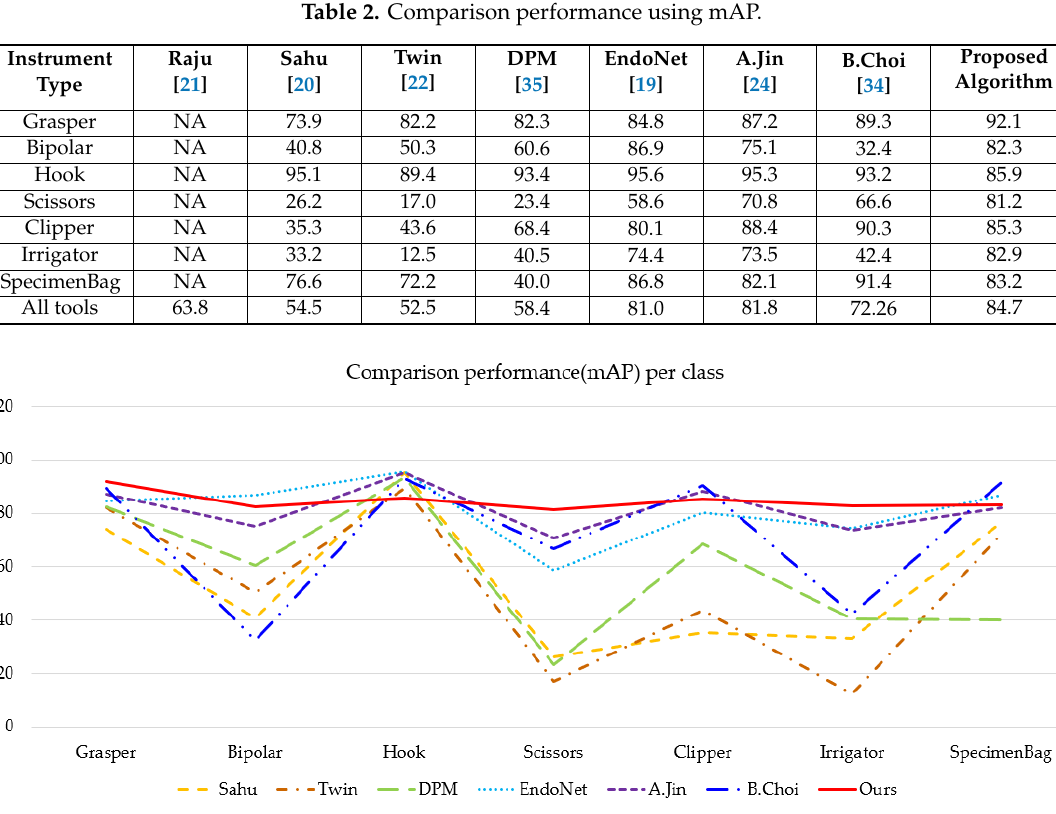
Table 2. Comparison performance using mAP.